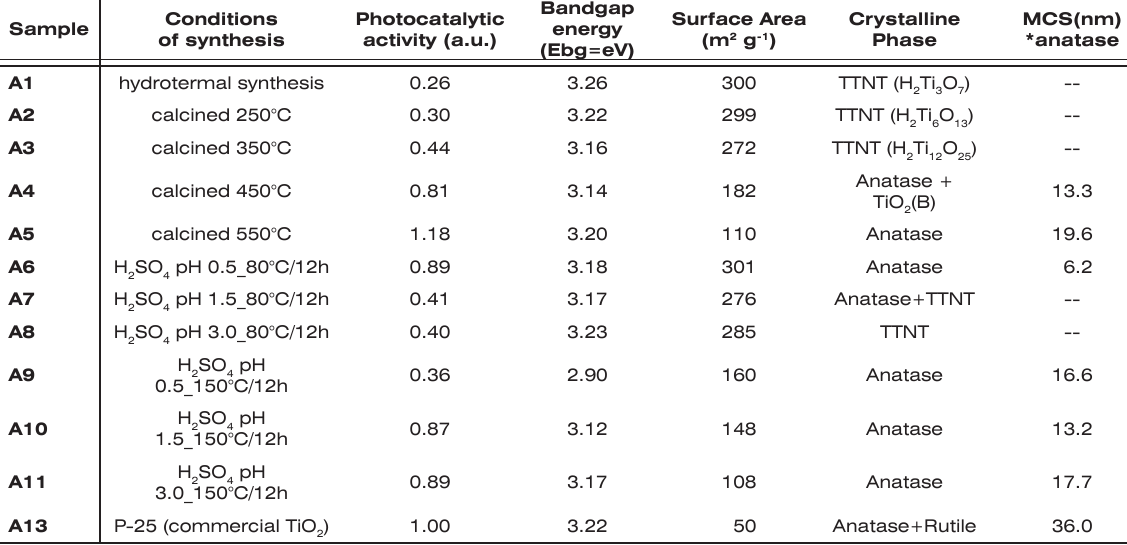
Table 1. Sample labels, their synthetic conditions, catalytic activity and physical